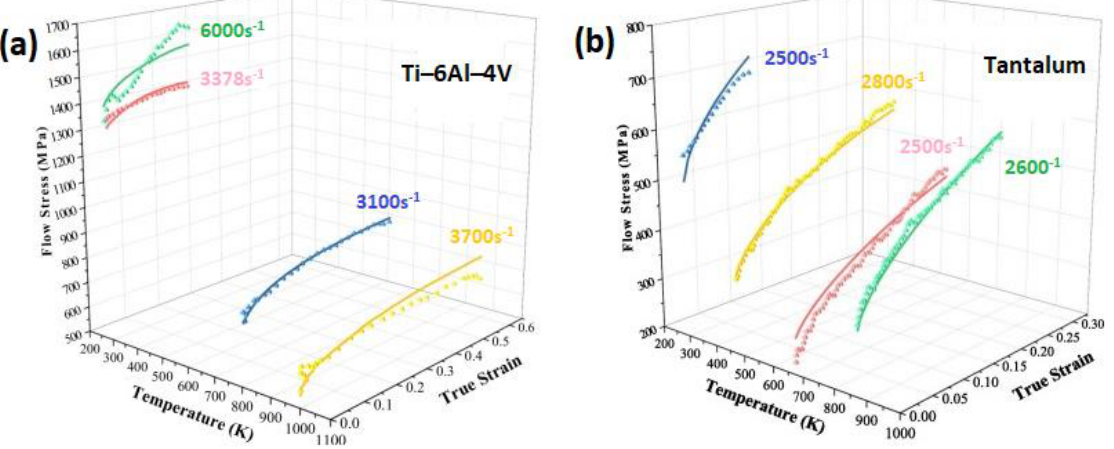
Figure 50. Experimental stresses (markers) compared to predicted stresses (solid lines) for the prediction of flow behavior using the modified JC that was presented by Wang et al. [95] for ( a ) Ti – 6Al – 4V and ( b ) tantalum.